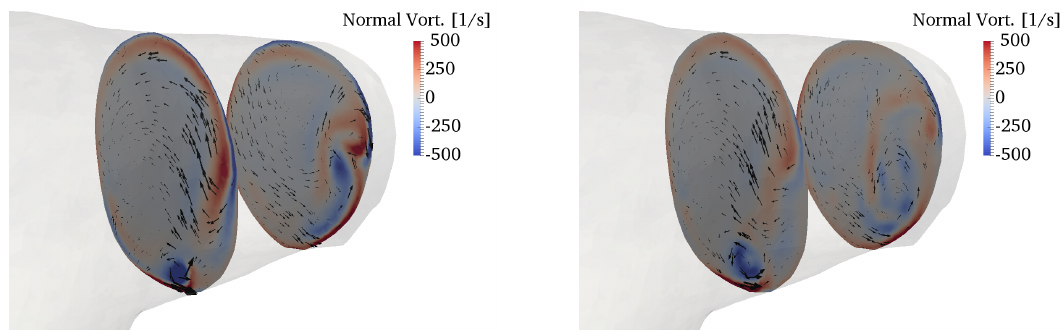
Figure 13. Secondary motions visualized by in-plane velocity vectors and contours of normal vorticity in the RPA (top) and LPA (bottom). The left column refers to peak systole, while the right column to the deceleration